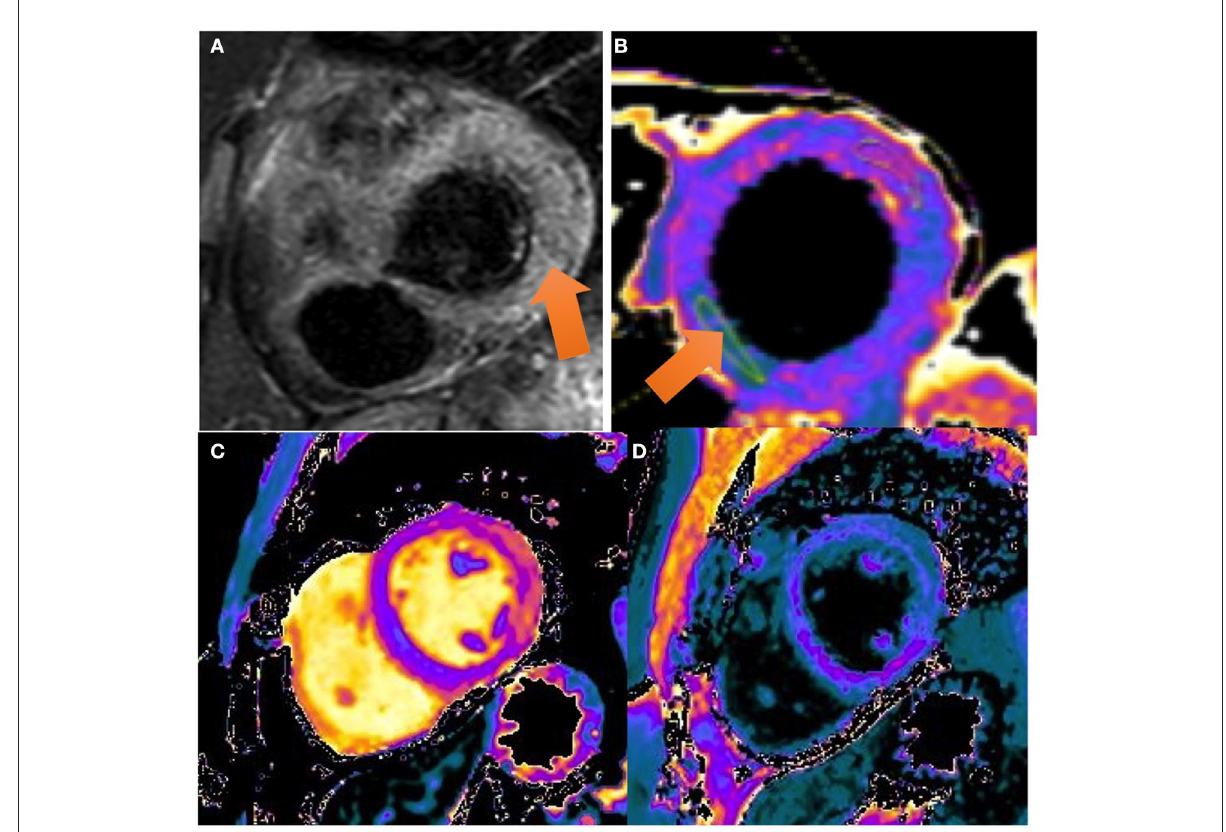
FIGURE2 CMR images: the balanced FFE (fast field echo) sequences acquired along the short axis (A, B) and two chamber (C) and four chamber (D) views demonstrate myocardial late gadolinium enhancement with epicardial predominance in the lateral and inferior wall and mesocardial predominance in the septum and anterior wall (view